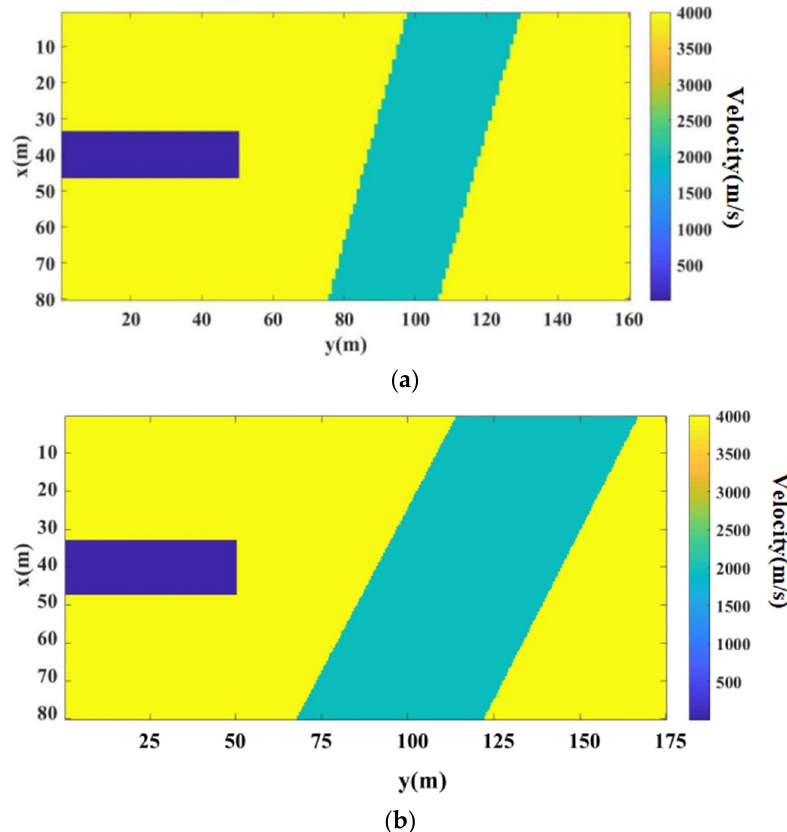
Figure 7. ( a ) A 30 m thick fault rock wave velocity numerical model. ( b ) A 110 m thick fault rock wave velocity numerical model.